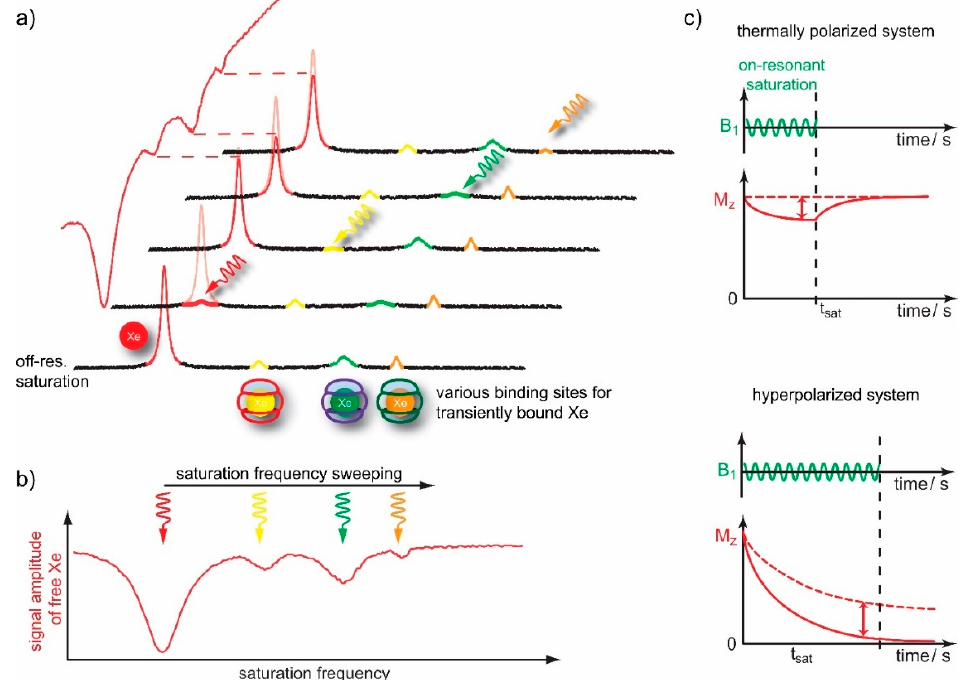
Figure 6. Concept of HyperCEST detection. ( a ) Pseudo-2D spectroscopy data set for preserving the spectral dimension in HyperCEST. ( b ) z-spectrum derived from data in a) ( c ) Time scales in CEST with thermally polarized nuclei ( 1 H) and HyperCEST with induced saturation being faster than intrinsic relaxation.